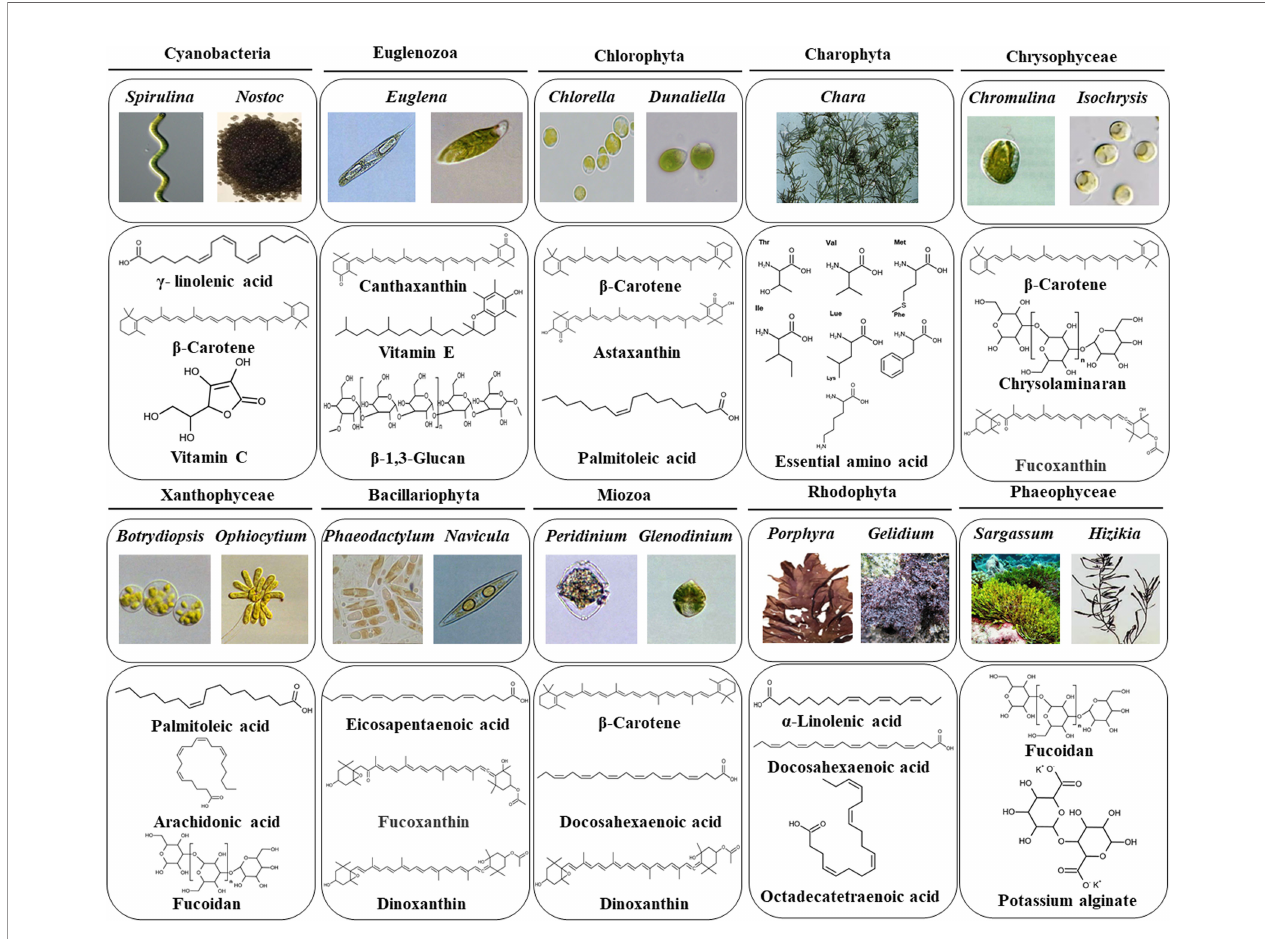
FIGURE 1 | Representative algae species and pharmaceutical components in ten major